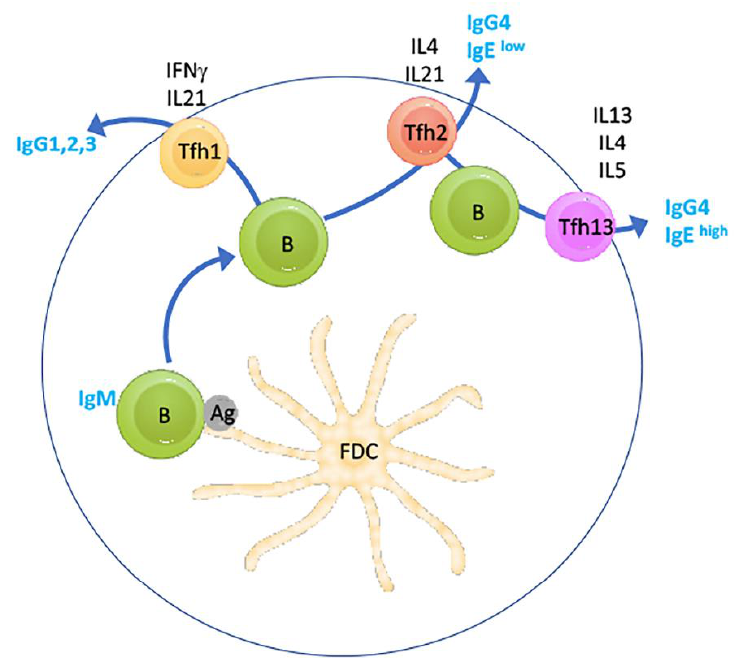
Figure 2. Function of IL-13-dependent TfH cells in IgE production in response to allergens. Simplified schematic showing the light zone of a peripheral lymphoid germinal centre (GC) where a naïve IgM-positive B cell survives apoptosis after antigen (Ag) encounter presented by a follicular dendritic cell (FDC). Prior and additional interaction with Th cells are not shown. Depending on the type of antigen, the B cell may then receive stimulation by TfH1 cells, resulting in class switching to Ig-isoforms, as indicated. Further, sequential stimulation by TfH2 cells may cause secondary class switching to IgG4 or IgE low phenotypes. Finally, the newly identified IL-13-dependent TfH13 cells, may cause tertiary switching to IgE high in the context of allergen stimulation. The schematic is based on figures in [61] and [63].